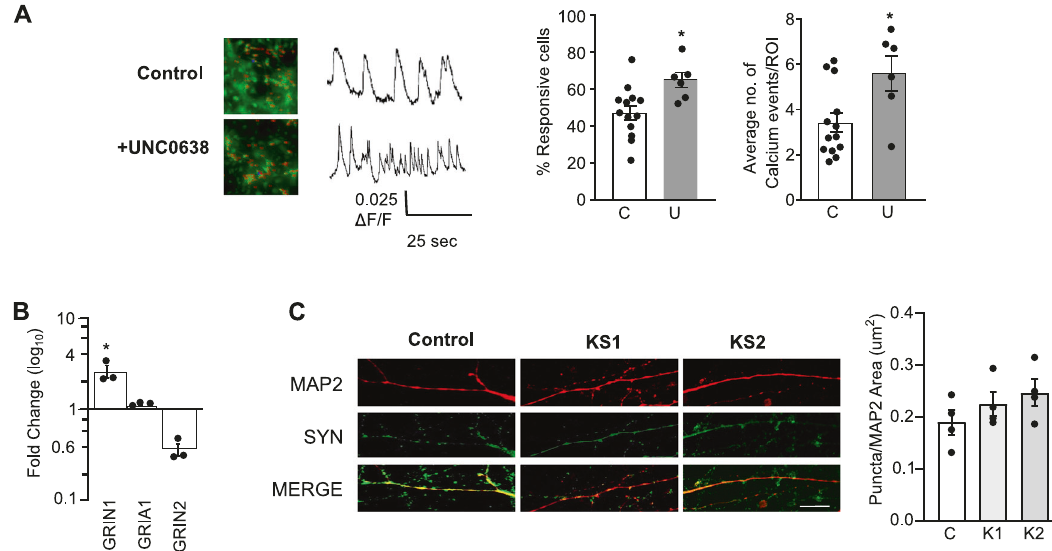
Fig. 6 Reduced EHMT activity leads to aberrant neuronal activity. A Calcium imaging of hiPSCs-derived neurons. Differentiated neurons were analysed for spontaneous calcium events using Cal-520tm AM staining. Neurons were treated with UNC0638 for two weeks and calcium imaging was performed around day 50 of differentiation to compare the number of calcium event frequencies between control neurons and those treated with UNC0638. Representative images and traces of calcium in fl ux of neuronal cultures in the presence and absence of UNC0638 (250 nM) are shown. Vertical scale bar shows 0.025 ( Δ F/F); horizontal bar shows 25 s. N = 300 ROIs for all cell lines across 2 imaging regions over 3 coverslips/line. The percentage of responsive cells and average calcium events/ROIs for control untreated hiPSCs and cells treated with UNC0638. B qRT-PCR analysis to examine changes in the expression of GluN1, GRIA1 and GRIN2A in EHMT1 − / + -derived neurons relative to their expression in isogenic control neurons. The expression of GRIN1 was signi fi cantly elevated in EHMT1 − / + cells, while those of GRIA1 and GRIN2A were unchanged, n ≥ 3. Error bars represent SEM, all data points shown, * P < 0.05. C Equivalent stage neurons derived from KS-patient iPSC and control hiPSC were stained for neuronal marker MAP2 and the synaptic marker Synaptophysin positive puncta normalised to the dendritic area stained positive for MAP2. No signi fi cant difference in synaptic density, measured by the number of synaptophysin- stained puncta per unit area of MAP2 stained neurite, was observed. Representative images of Synaptophysin (SYN, green) positive puncta in MAP2 (red) positive control, KS1 and KS2 neurons. Scale bar = 50 µm. n ≥ 3 independent experiments. Data shown as Mean±SEM and analysed by student ’ s t-test or One-way ANOVA with post hoc comparisons using Dunnett ’ s multiple comparisons test comparing to control